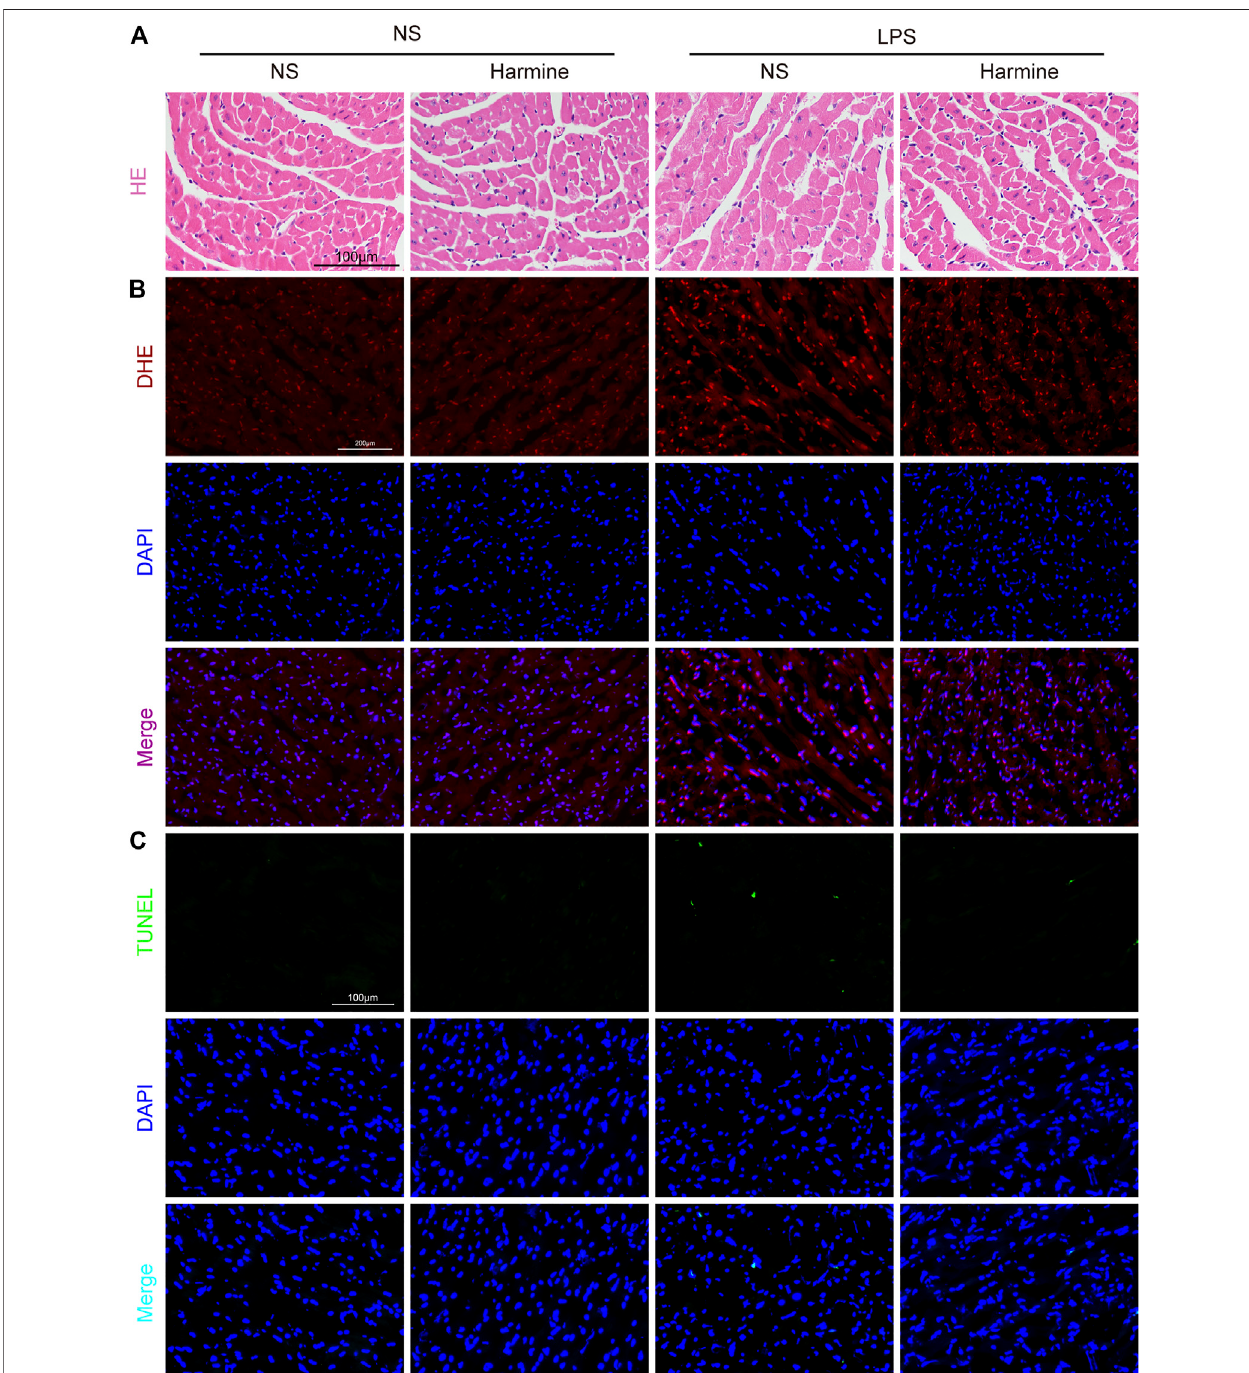
FIGURE 5 | Harmine restrained sepsis-induced cardiac disarrangement, oxidative stress and apoptosis. (A) Representative images of H&E staining in the myocardium (400X, scale bar: 100 μ m). (B) Representative images of DHE staining (200X, scale bar: 200 μ m). DHE (red) and DAPI (blue). (C) Representative images of TUNEL staining in the myocardium (200X, scale bar: 100 μ m). TUNEL (green) and DAPI (blue).